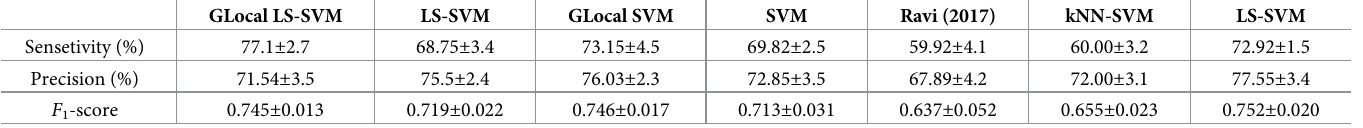
of the GLocal-LS-SVM (with 30 partitions) is compared to those of the LS-SVM model, GLocal-SVM (with 30 partitions), and SVM in addition to best performing state-of-the-art models for this dataset, namely, the deep learning approach (Ravi2017), kNN-SVM, and kNN-LS-SVM. The comparative methods are chosen to be global and localised models to allo- cate the performance of GLocal-LS-SVM between them. The experiment setup of GLocal- LS-SVM and LS-SVM is similar to that of the state-of-the-art [7]. In Table 9, the sensitivity, precision, and F -score of the GLocal-LS-SVM model are compared to those of LS-SVM, 1 Table 10, the time performance of the four models (GLocal-LS-SVM, LS-SVM, GLocal-SVM, and SVM) is depicted in terms of seconds reflecting the average elapsed time to develop the local models, accumulated loacl models, global models, and total the modelling time for each approach. Table 9. Comparing the average error performance of the GLocal LS-SVM, LS-SVM, Ravi (2017), kNN-SVM, and kNN-LS-SVM models applied to the Daphnet FoG dataset.